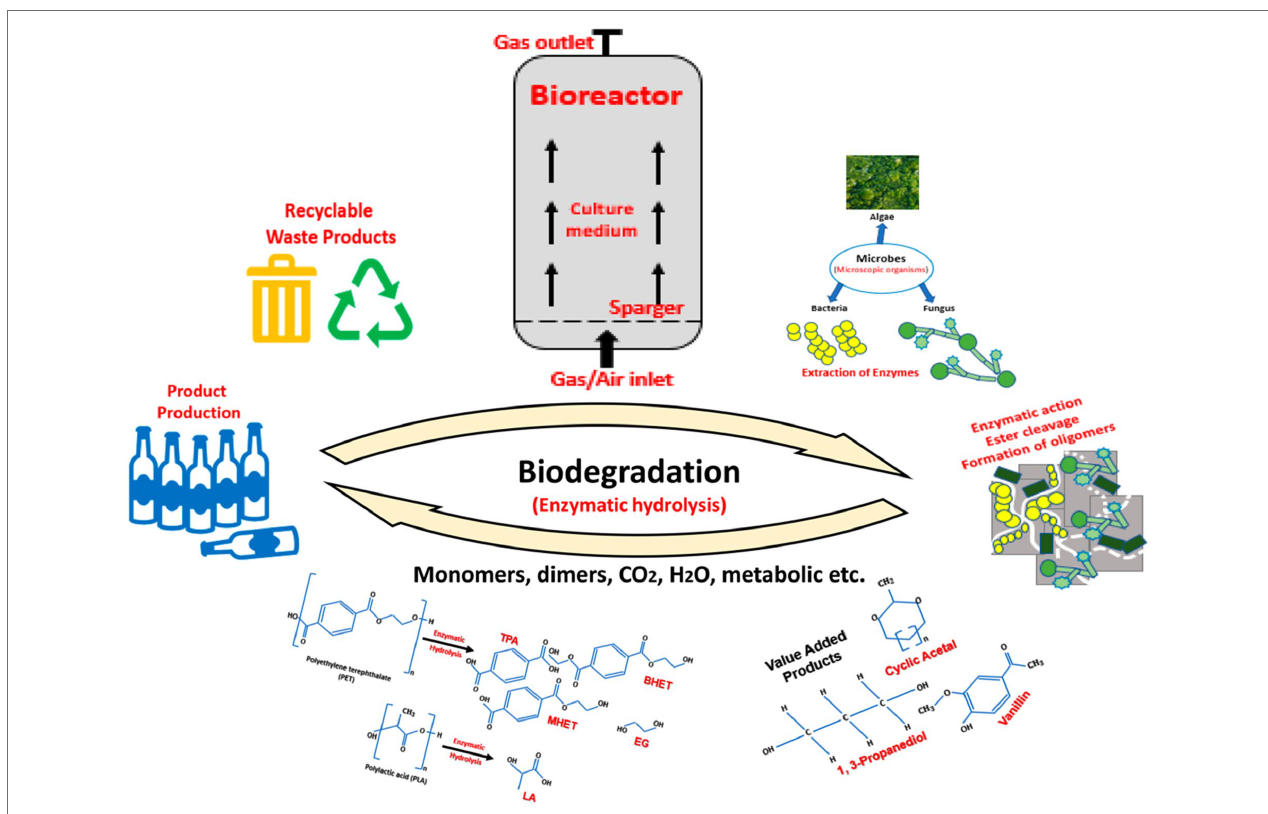
FIGURE 1 | Schematic workflow of the biodegradation of plastic waste through enzymatic hydrolysis. The biodegradation of PLA-PET plastic waste is dependent on the diversity of the microorganisms and the environmental/experimental conditions. At a commercial level, this biological process occurs in bioreactors. The culture medium in the bioreactors results in the production of enzymes by the microbes. After excretion of the enzymes, they attach to the external surface of the plastic. As time passes, owing to their enzymatic activity, cracks appear on the polymer surface, subsequently causing it to decompose into lower molecular weight units, i.e., monomers and the other value-added products. The recycled monomers can be reused as a resin for polymer